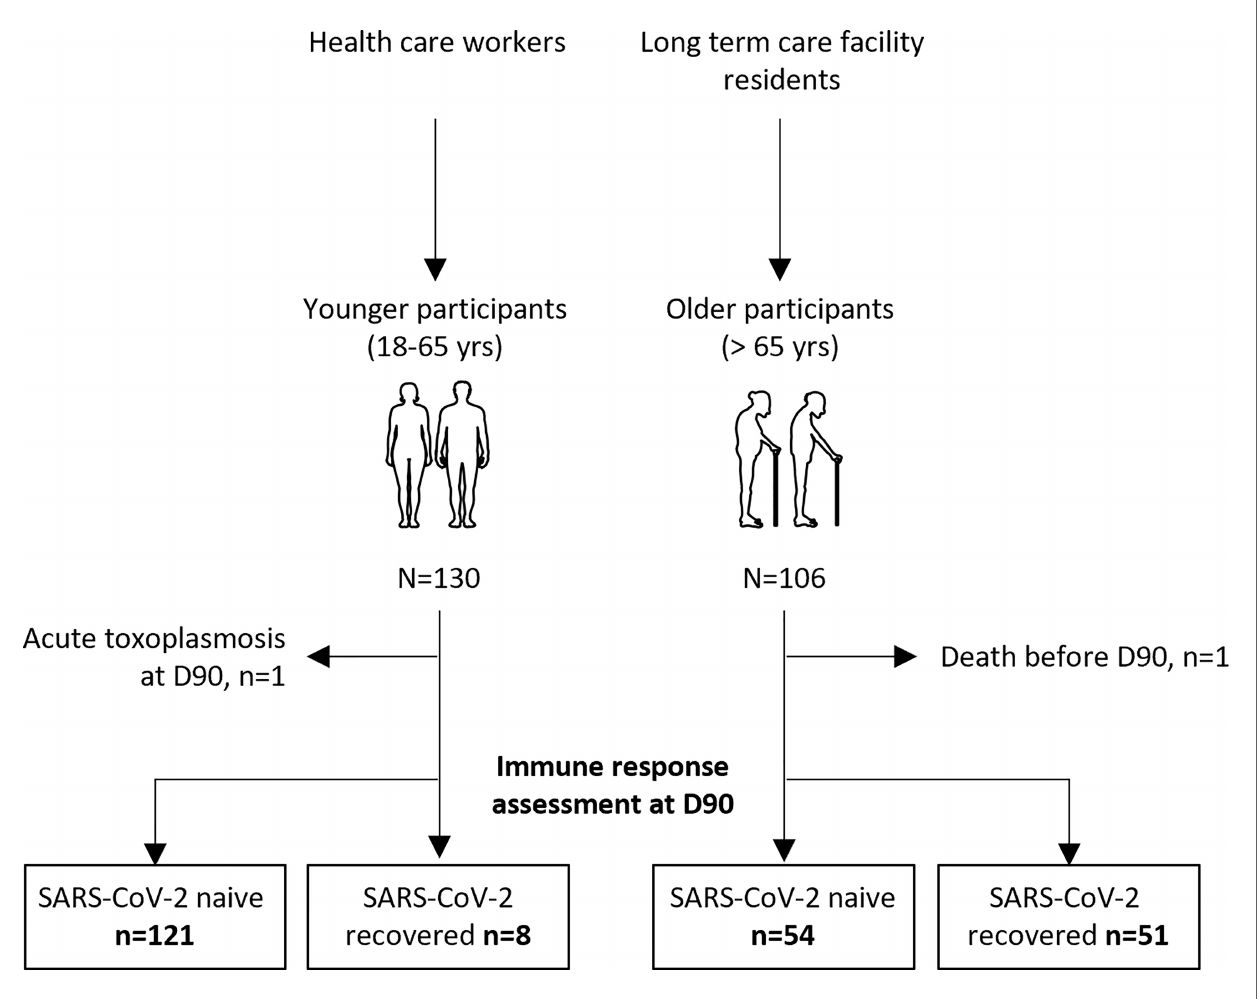
FIGURE 1 | Flow chart of the